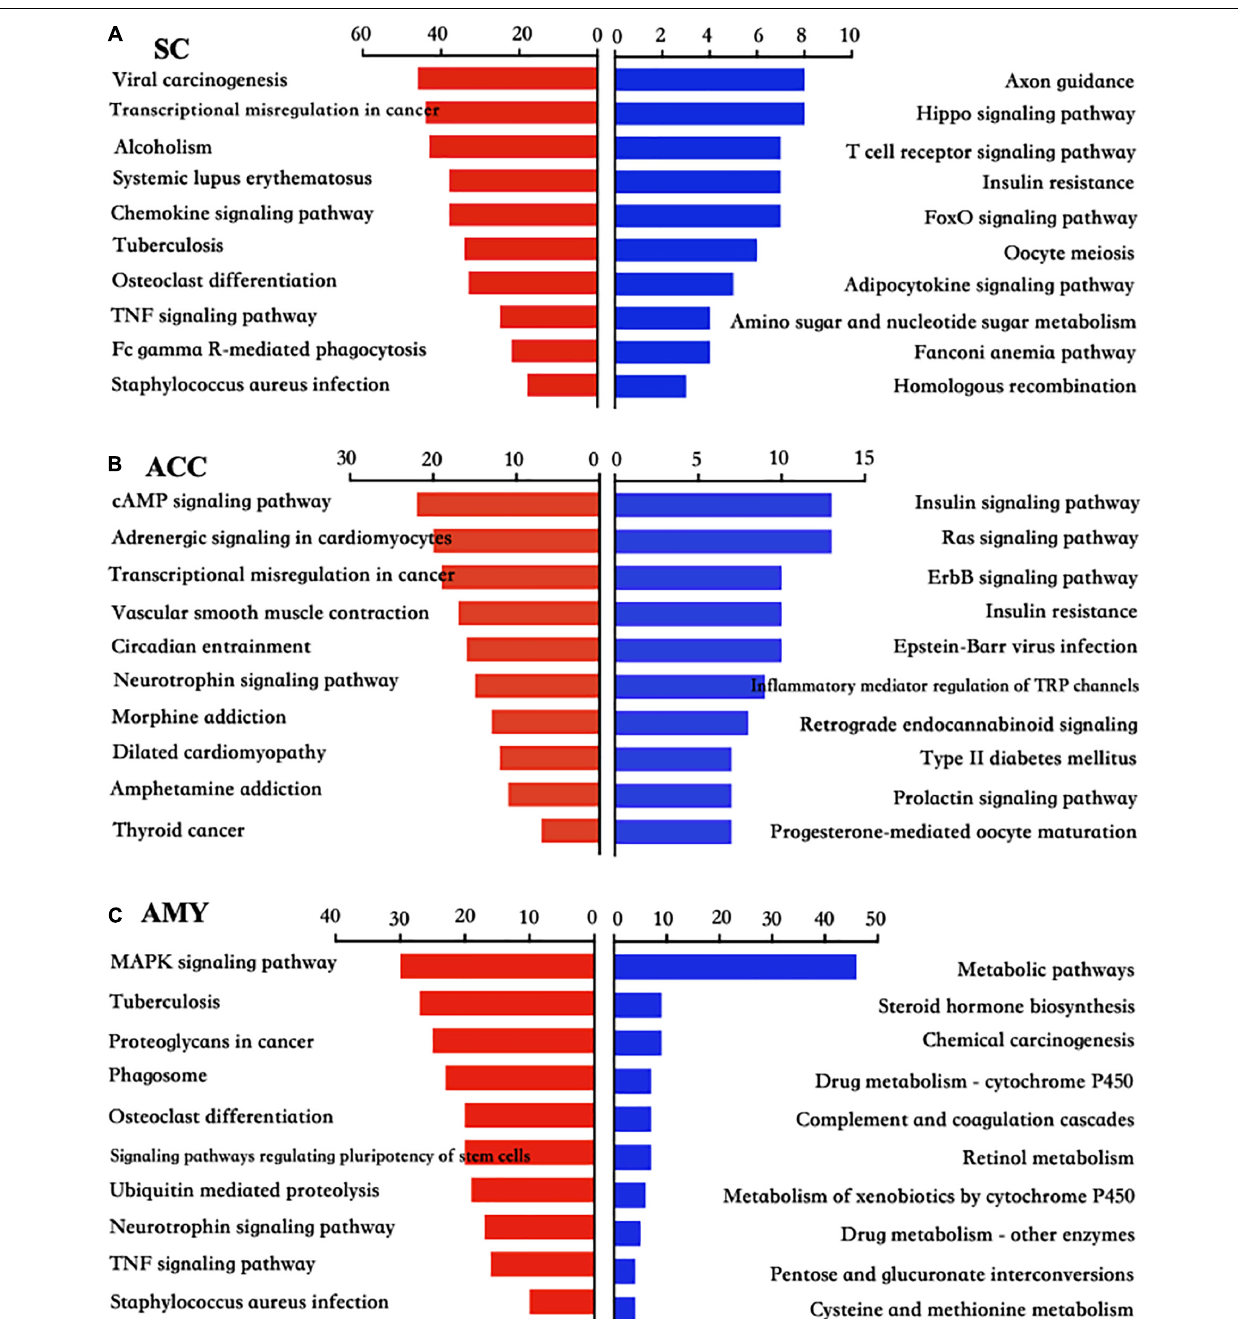
FIGURE 6 | KEGG pathway analysis of the differentially up- and downregulated mRNAs in the SC, ACC, and AMY after nerve injury. (A–C) The top 10 enrichments of KEGG pathways from upregulated mRNAs (red panels on the left) and downregulated mRNAs (blue panels on the right) in the SC (A) , ACC (B) , and AMY (C) on day 7 post-SNL according to the P -value. The DAVID database was used to do the KEGG pathway analysis. Red and blue bars represent up- and downregulated mRNA enrichments,